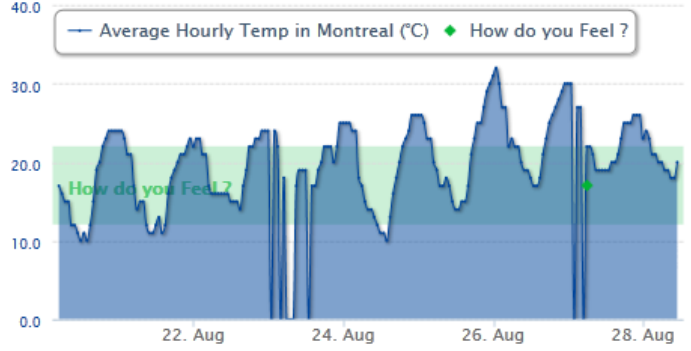
Figure 16. Example of Data Stream Infographic Available on the Sen.se